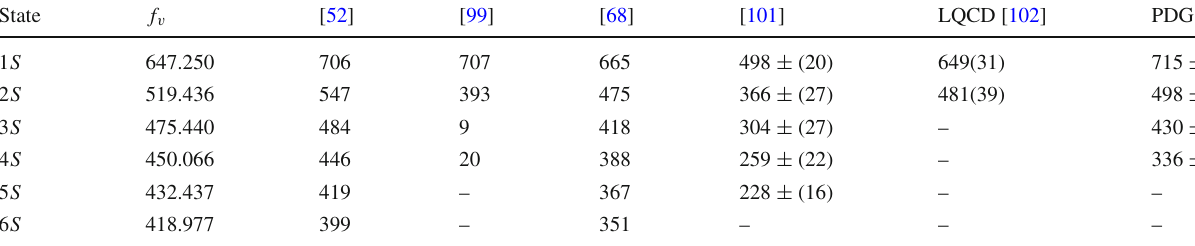
Table 11 Vector decay constant of bottomonia (in MeV)